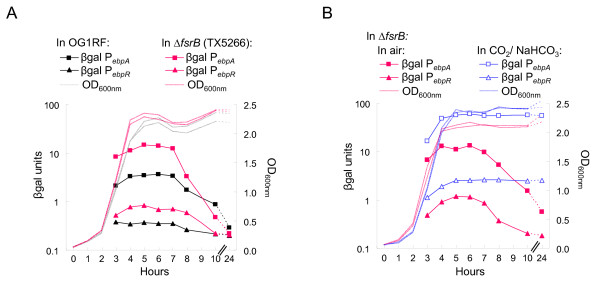
ebpR and ebpA expression profiles in TX5266 (ΔfsrB mutant). For β-gal assays, samples were collected every hour from 3 to 8 hr, then at 10 and 24 hr after starting the culture (x axis). The left axis represents the β-gal units (OD420nm/protein concentration in mg/ml). The right axis indicates the OD600 nm readings. All sets of cultures presented were analyzed concurrently. Each figure is a representative of at least three experiments. A. OG1RF containing either PebpR::lacZ (black triangle) or PebpA::lacZ (black square) and ΔfsrB containing either PebpR::lacZ (pink triangle) or PebpA::lacZ (pink square) were grown in TSBG aerobically. B. The ΔfsrB mutant (TX5266) containing either PebpR::lacZ (triangle) or PebpA::lacZ (square) was grown in TSBG aerobically (pink closed symbol) or in the presence of 5% CO2/0.1 M NaHCO3 (open blue symbol).